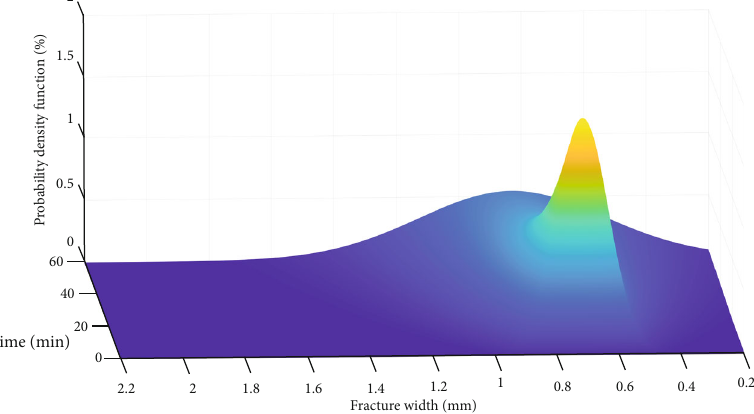
Figure 14: Probability density function for fracture width for time interval t = ½ 0, 60 (cid:2)